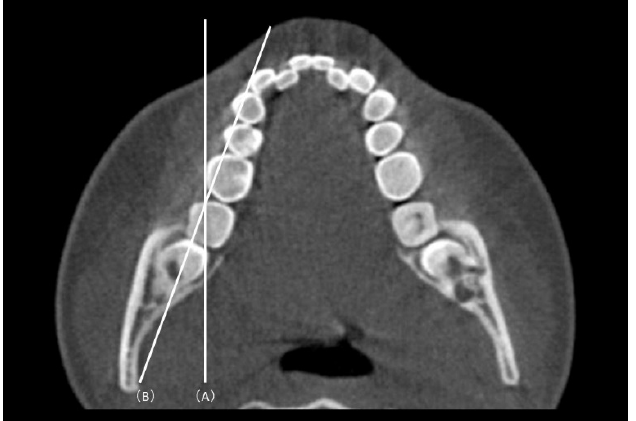
Figure 2. Plane used to measure the mandibular posterior anatomic limit to the mandibular cortex of the lingual bone. Reference plane (0) parallel to the mandibular occlusal plane passing through the root furcation of the mandibular right second molar. Reference planes (2), (4), and (6) are located 2, 4, and 6 mm, respectively, from reference plane (0) toward the root apex.